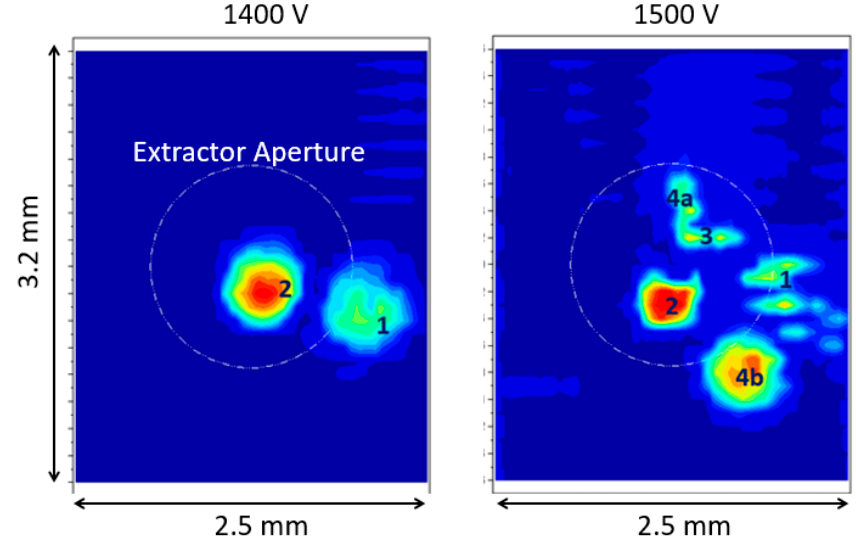
Figure 18. Spatially resolved current measurements at extraction voltages of 1400 and 1500 V. Numbers identify individual beamlets.